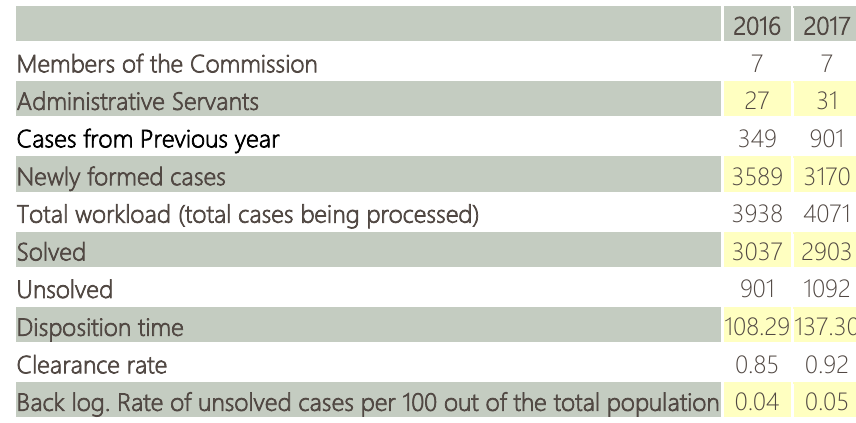
Table 3: State Commission for Decision Making in Second Instance Inspection Oversight and